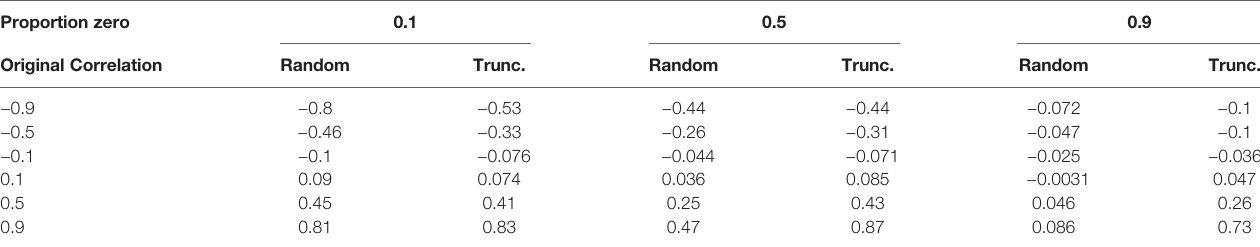
TABLE 1 | Effect of different levels of sparsity (proportion of zeros) on the standard Pearson (sample) product-moment correlation coef fi cient. Proportion zero 0.1 Original Correlation Random Trunc. Random Trunc. Random